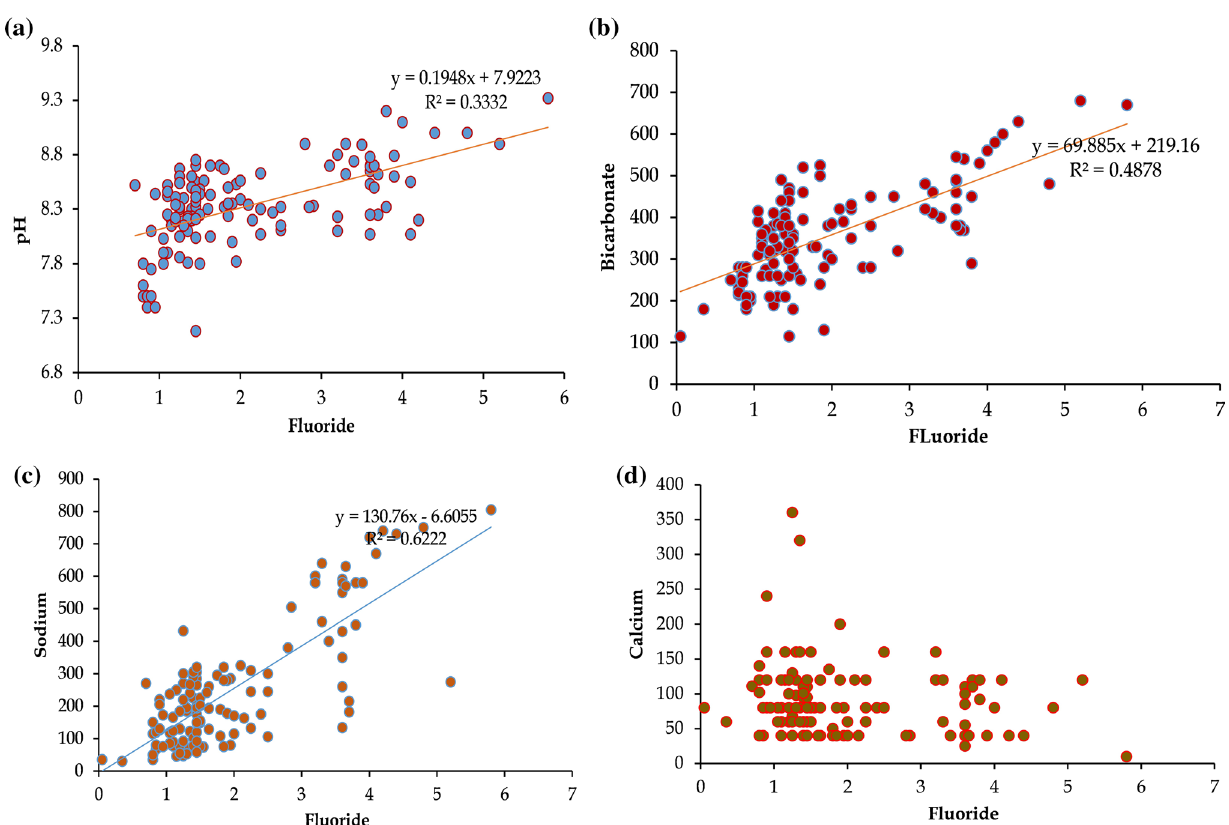
Fig. 6 Correlation between a fluoride and pH, b fluoride and bicarbonate, c fluoride and sodium, and d fluoride and calcium in the groundwater of Markapur,